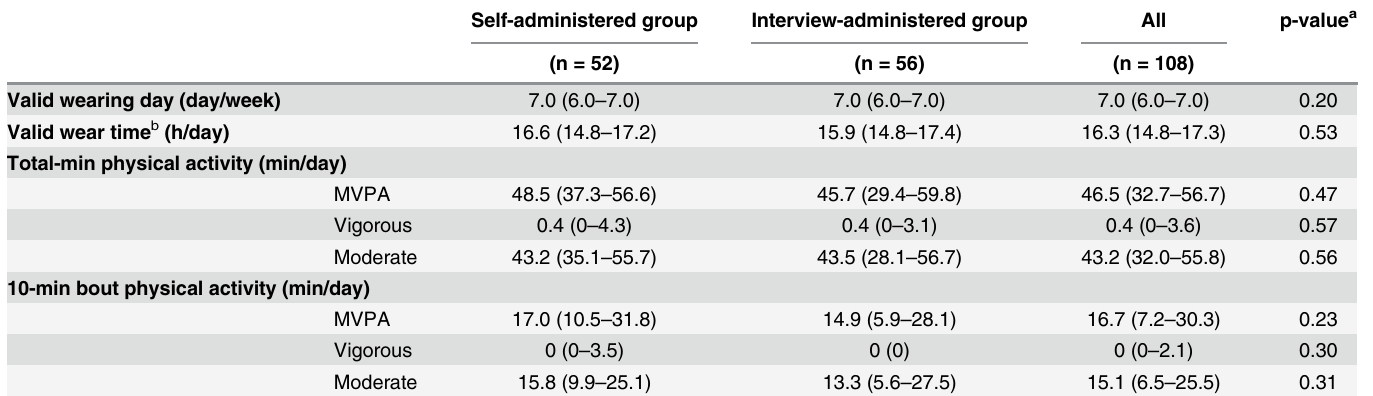
Table 4. Accelerometry-based physical activity summary estimates (median,